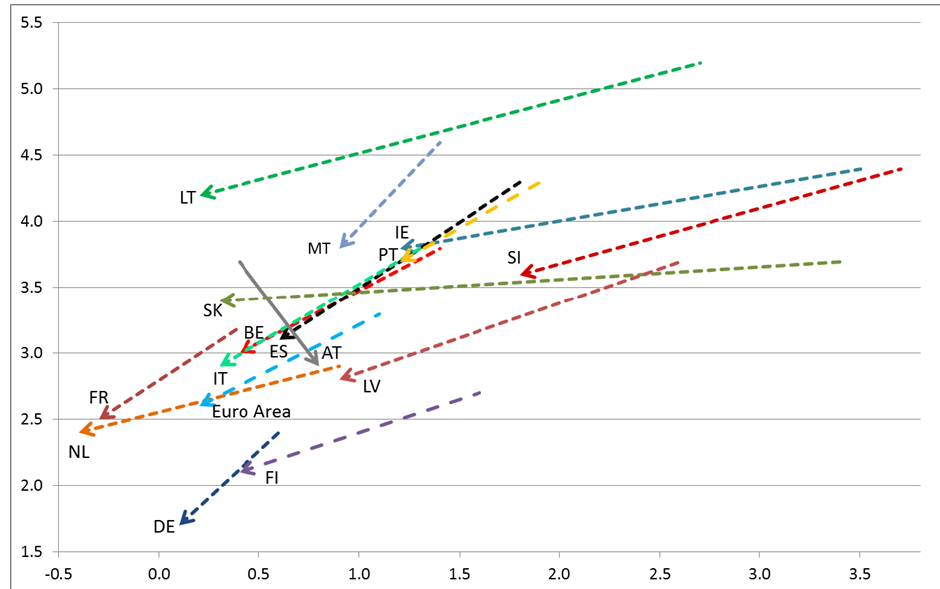
Figure 10. Government debt securities issued by euro area governments, average yield (x-axis: yield on debt securities issued over the last 12 months in December 2016 compared to May 2014; y-axis: yield on the stock of debt securities in December 2016 compared to May 2014; percentages per annum). Source: ECB. Note: National data exclude Greece, Cyprus, Estonia and Luxembourg. The deviating pattern for Austria may be related to the downgrade of its credit rating from AAA to AA and its issuance of two relatively expensive bonds with an ultra-long maturity of 30 and 70 years.